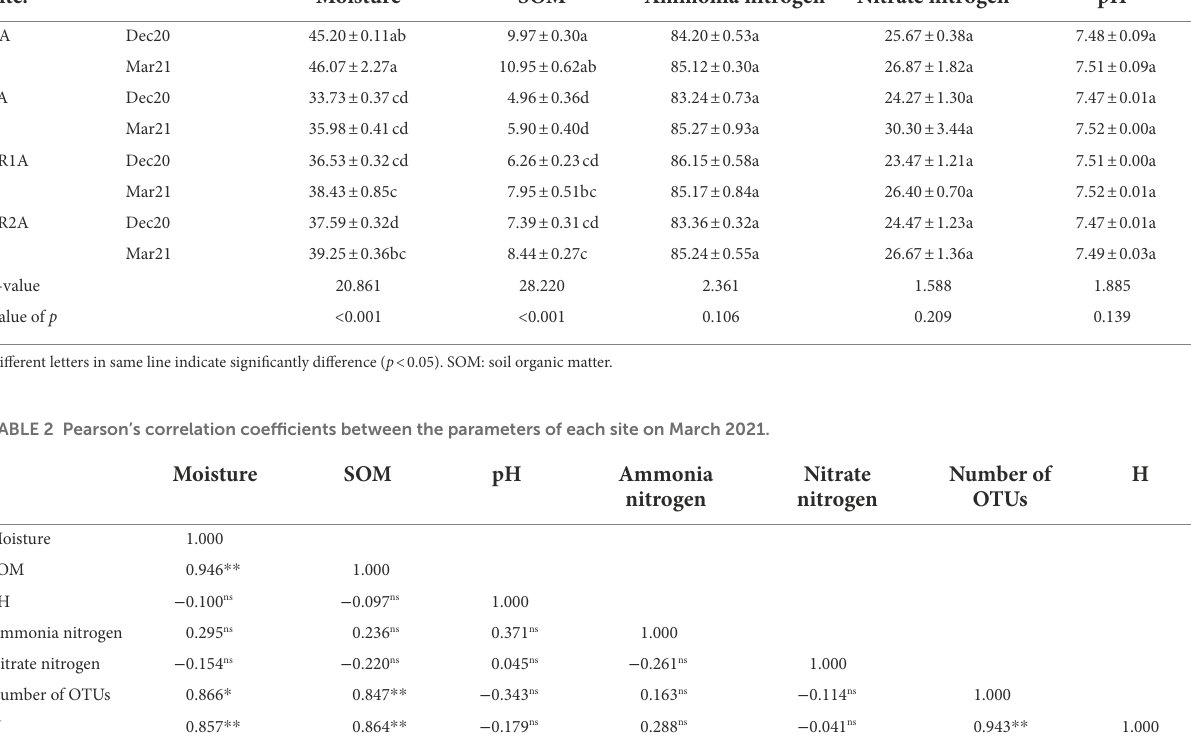
TABLE 1 Values (mean ± SD) of soil properties of each site in December 2020 and March 2021. Site.